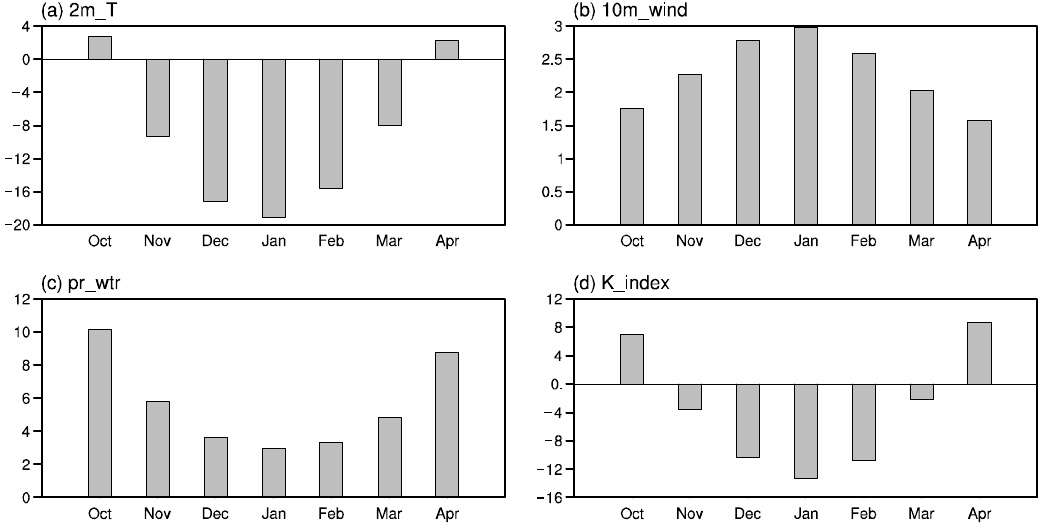
Figure 3. Winter climatic elements over NEC during 1961–2017: ( a ) 2-m air temperature (units: ◦ C); ( b ) 10-m wind speed (units: m s − 1 ); ( c ) precipitable water (units: kg m − 2 ); ( d ) K-index (units: K).